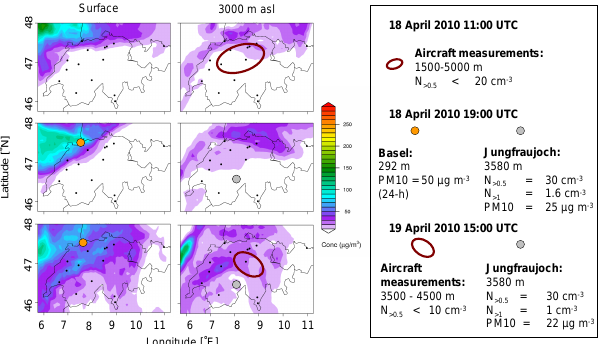
Fig. 14. 17 April 2010: comparison of the simulated volcanic ash concentration (surface and 3000ma . s . l . ) with the number and/or mass concentration values retrieved from the in-situ measurements.